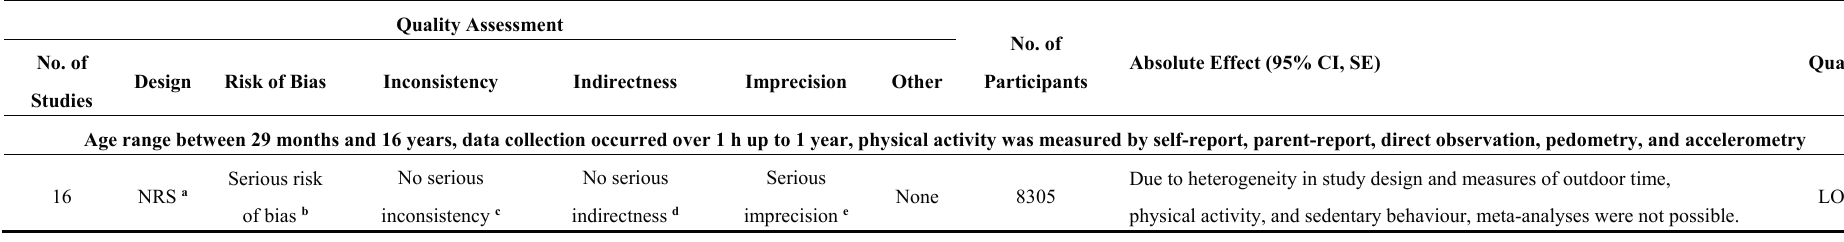
Table 1. Associations between outdoor time and habitual physical activity in